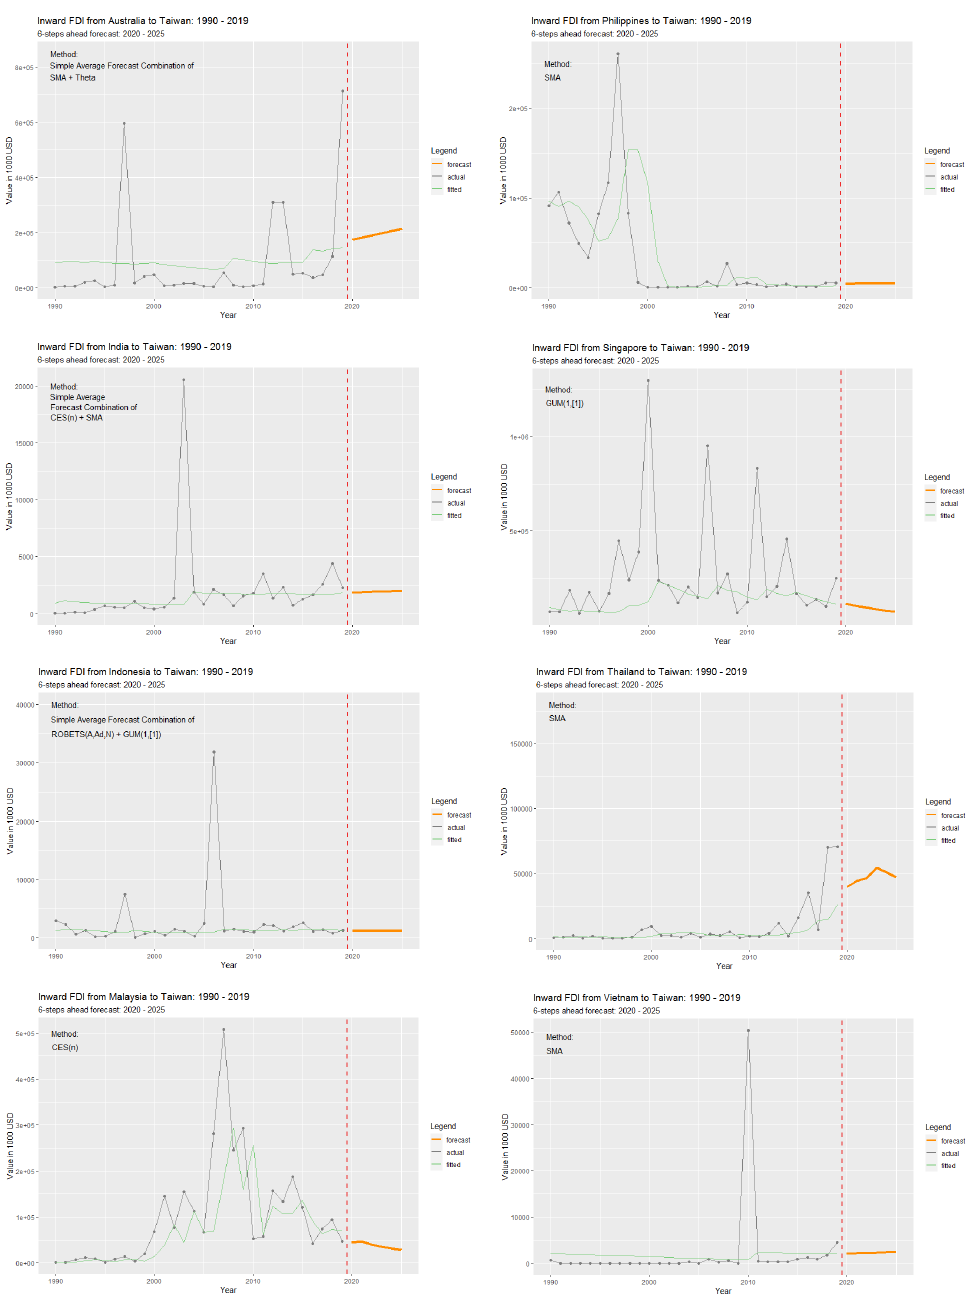
Figure A4. Inward FDI forecasts from eight NSP counterparts to